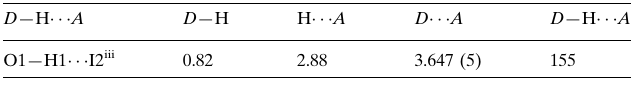
Hydrogen-bond geometry (A˚ , (cid:2)